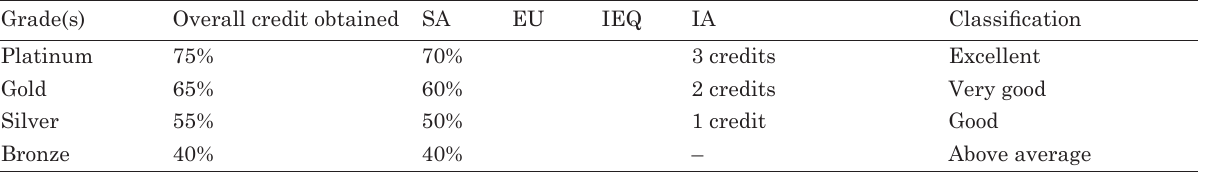
Table 2. Threshold scores for obtaining award classifications under BEAM